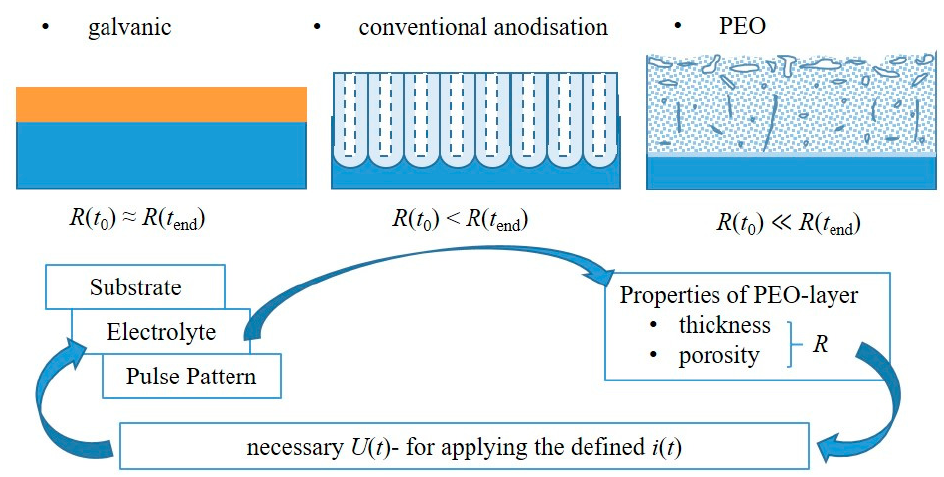
Figure 7. Schematic representation (not to scale) of obtained-layer morphology and development of layer resistance R for different electrolytic coating methods relation to the process time t , interactions of the process variables voltage U ( t ) and current i ( t ) pattern with the layer characteristics during the PEO.